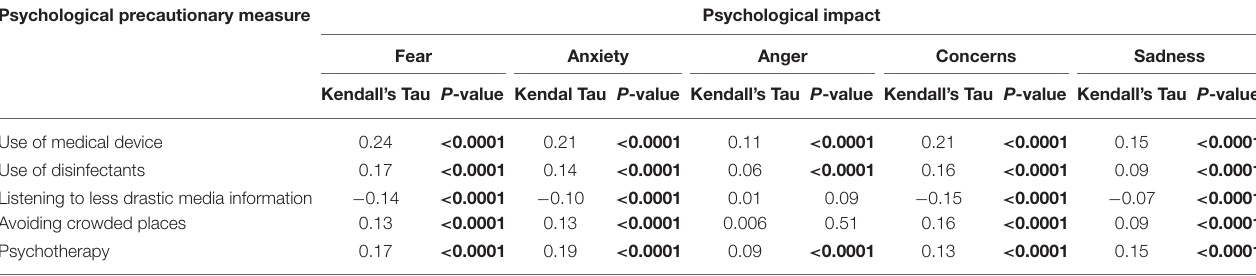
TABLE 8 | Correlations values (Kendall’s tau statistics) relating to “psychological impact and psychological precautionary measure” categories. Psychological precautionary